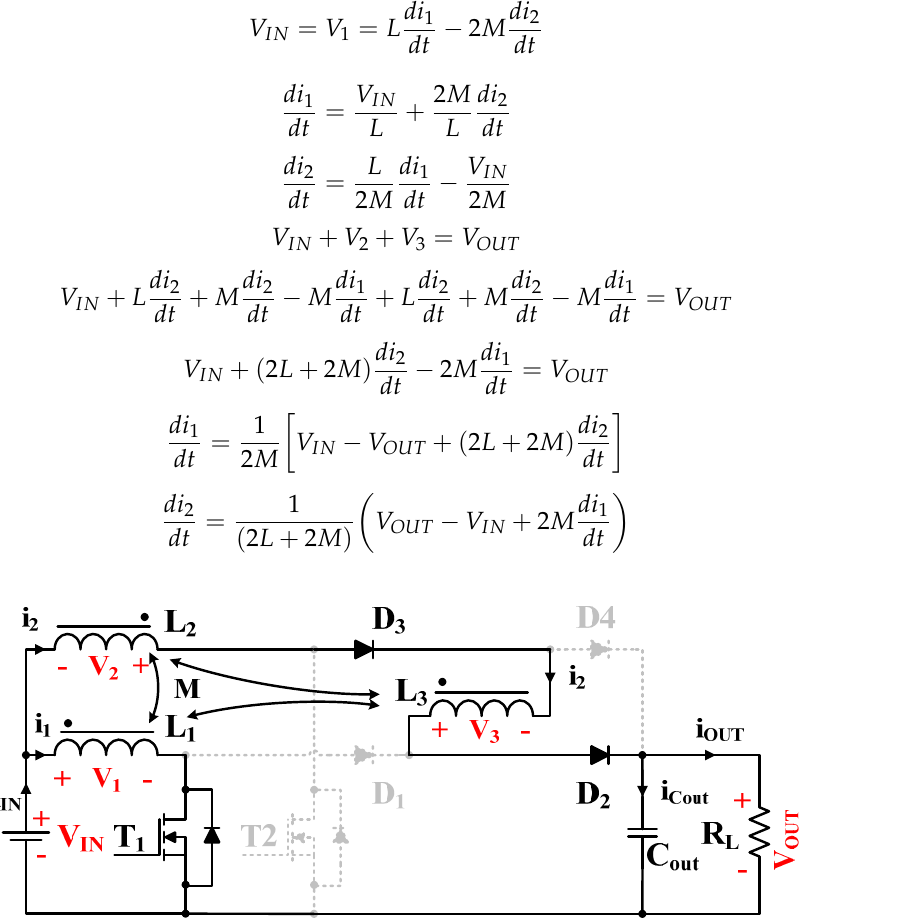
Figure 6. Equivalent circuit of proposed converter operation during 1st interval.